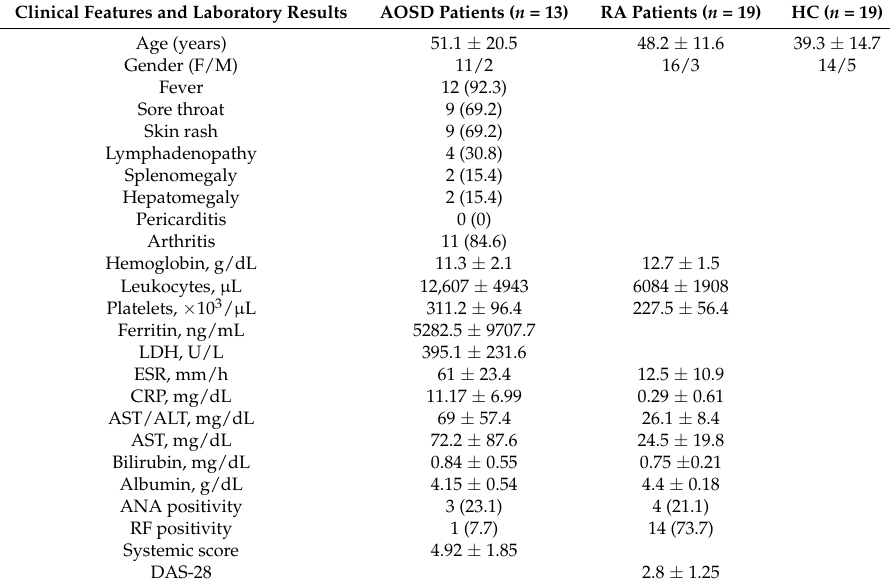
Table 1. Clinical characteristics of patients.